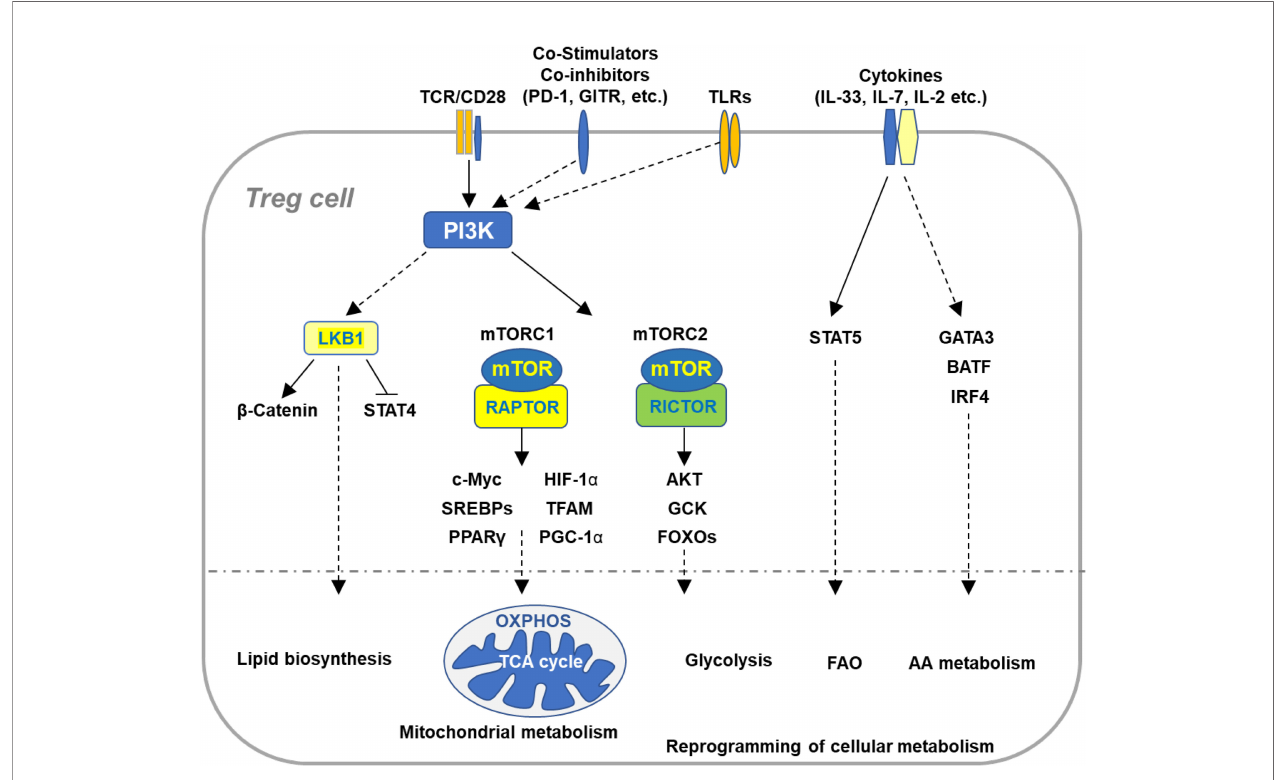
FIGURE 1 | Immune signaling pathways involved in the regulation of Treg cell metabolism and adaptation to non-lymphoid tissues. Microenvironmental antigens, co- stimulators, TLRs, and cytokines orchestrate key immune signaling pathways to reprogram cellular metabolism of Tregs in adaptation to non-lymphoid tissues. The PI3K signaling pathway senses the immune signals derived from TCR, co-stimulatory receptors, co-inhibitory receptors, and TLRs, which in turn activates mTOR complexes to orchestrate reprogramming of cellular metabolism via various transcription factors. TCR and co-stimulation activates LKB1 signaling pathway that restricts STAT4 function and promotes stabilization of b -catenin and metabolic reprogramming of Tregs in maintaining immune homeostasis of multiple non-lymphoid tissues. In response to TCR and co-stimulatory signals in the tissue microenvironment, Tregs coordinate a variety of transcription factors that upregulate expression of the genes involved in diverse metabolic programs, including lipid biosynthesis, mitochondrial metabolism, glycolysis, FAO, and AA metabolism. Cytokines existed in various tissues sustain homeostasis and accumulation of tissue Tregs through different transcription factors. VAT-Treg cell accumulation is dependent upon TCR, FOXP3, and IL-33 signaling through activation of GATA3, IRF4, and BATF. IL-7 is required to maintain homeostasis and function of skin-Tregs. TCR, T cell receptor; FAO, fatty acid oxidation; AA, amino acids; VAT, visceral adipose